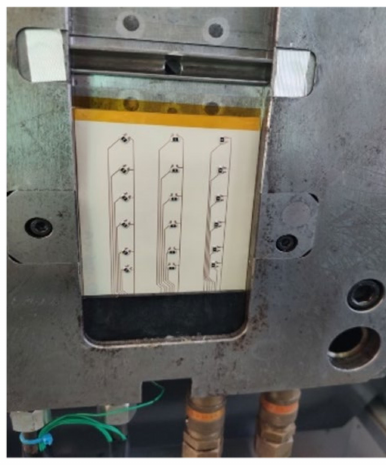
Figure 12. Foil fixed in a flat mold.